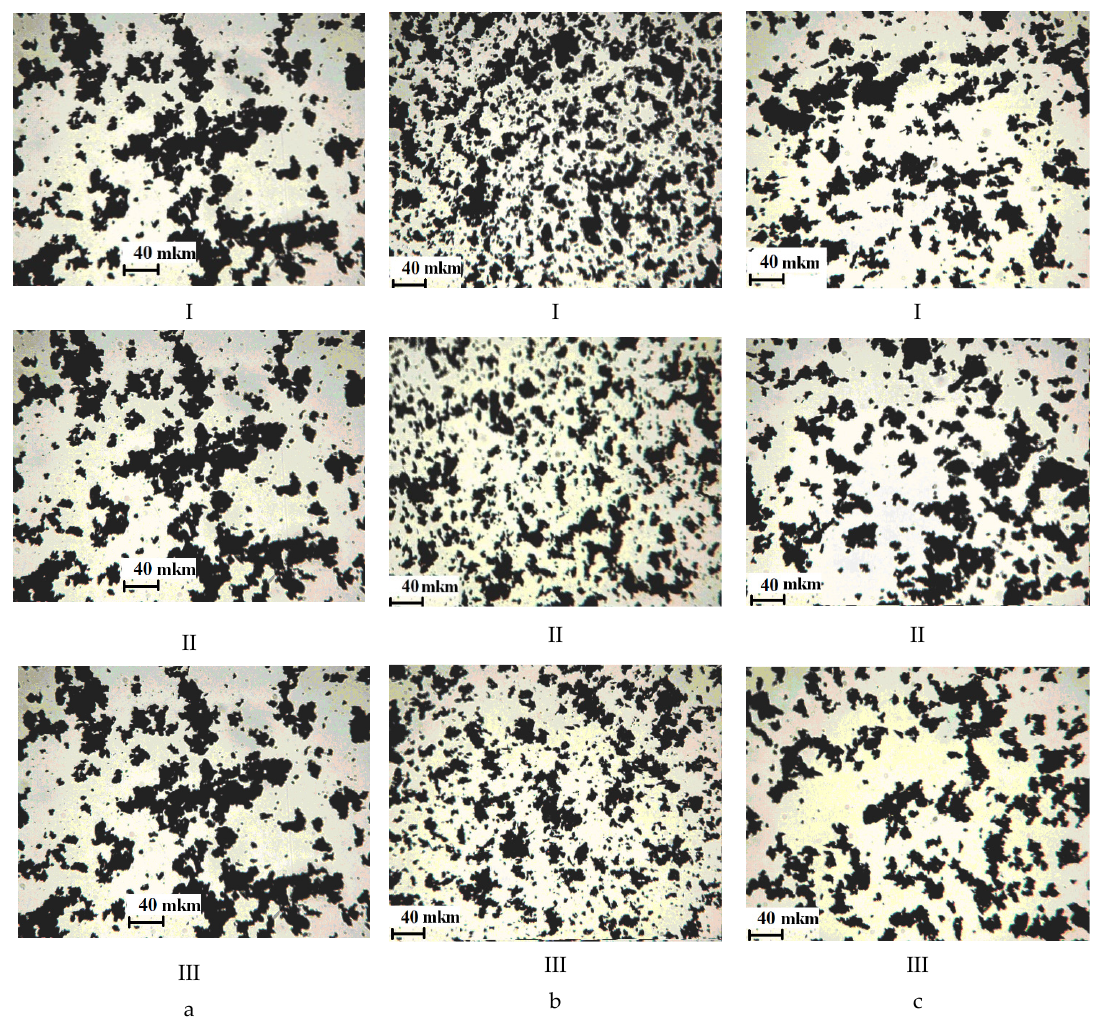
Figure 3. Micrographs of PPhS suspensions with different CS: I, PEPA; II, Telaz; and III, AS-1 for CS, g/dm 3 : ( a ), 0 g/dm 3 ; ( b ), 0.25 g/dm 3 ; and ( c ), 0.5 g/dm 3 .